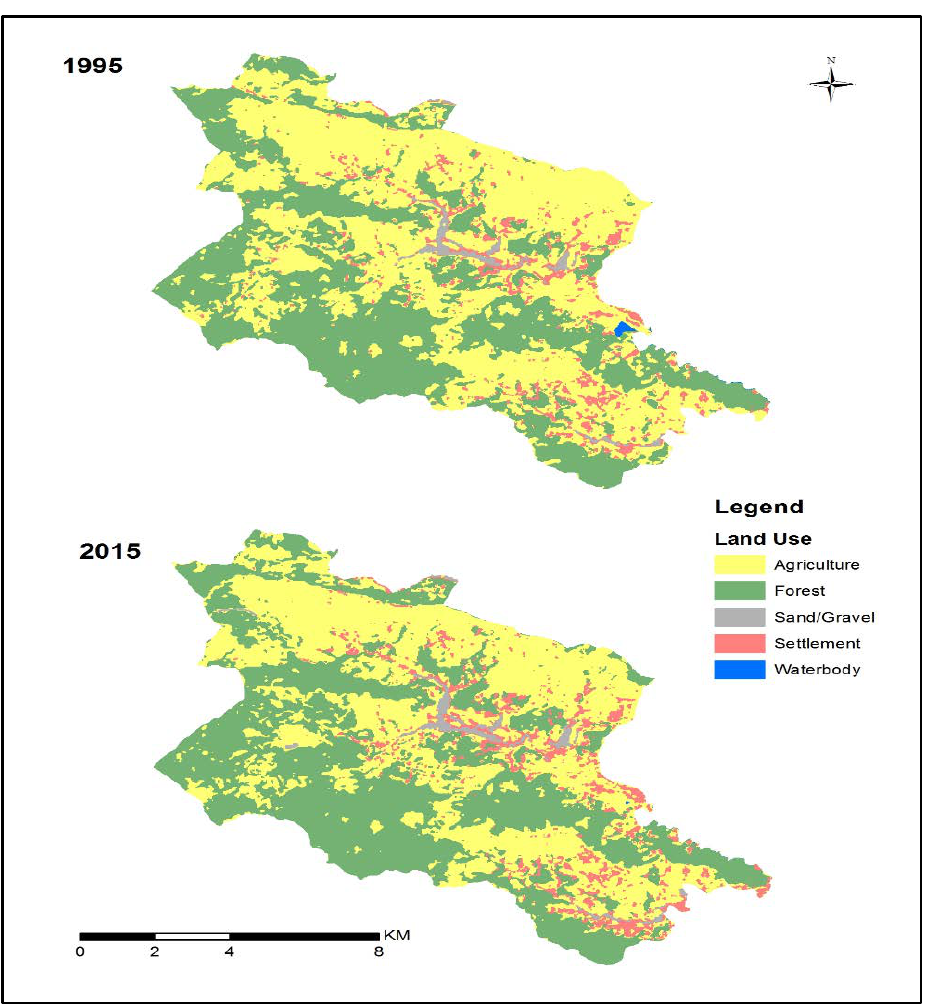
Figure 7. Land use map of the study area in 1995 and in 2015.